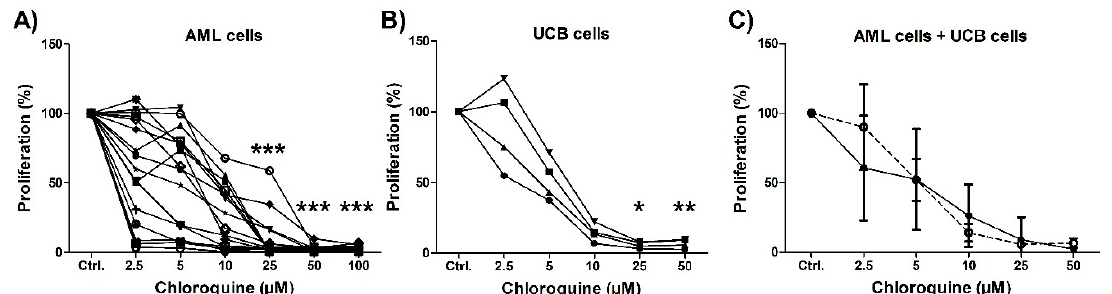
Figure 1. Initial in vitro drug screening study of chloroquine on patient-derived AML cells and UCB mononuclear cells. Cells were treated with chloroquine for six days before 3H-thymidine was added to cultures for an additional 22 h of incubation, before proliferation (nuclear incorporation) was determined by liquid scintillation counting. ( A ) Acute myeloid leukemia (AML) cells derived from 17 patients were treated with chloroquine at six different concentrations (2.5, 5, 10, 25, 50, and 100 µM), and ( B ) Umbilical cord blood (UCB) mononuclear cells from four donors were treated with chloroquine at five different concentrations (2.5, 5, 10, 25, and 50 µM). Detectable incorporation was defined as >1000 counts per minute (cpm). Results are shown as the percent proliferation of chloroquine-treated cultures compared to their respective untreated control cultures (set to 100%). At lower concentrations (2.5 and 5 µM) there was a varied sensitivity towards chloroquine, but at higher concentrations (10–100 µM) all samples showed decreased proliferation compared to untreated controls, * = p -value < 0.05, ** = p -value < 0.01, *** = p -value < 0.0001, Kruskal–Wallis, Dunn’s post-hoc test. ( C ) The figure shows the overall mean cell proliferation with SD, for all 17 AML patients (solid line) and four UCB donors (stippled line). There were no significant differences between the anti-proliferative effects of chloroquine on AML compared to UCB cells.